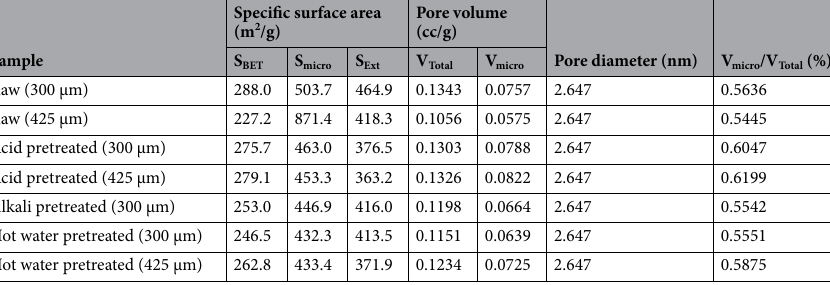
Table 8. Pore characteristics of rice husks biomass (raw and pretreated).